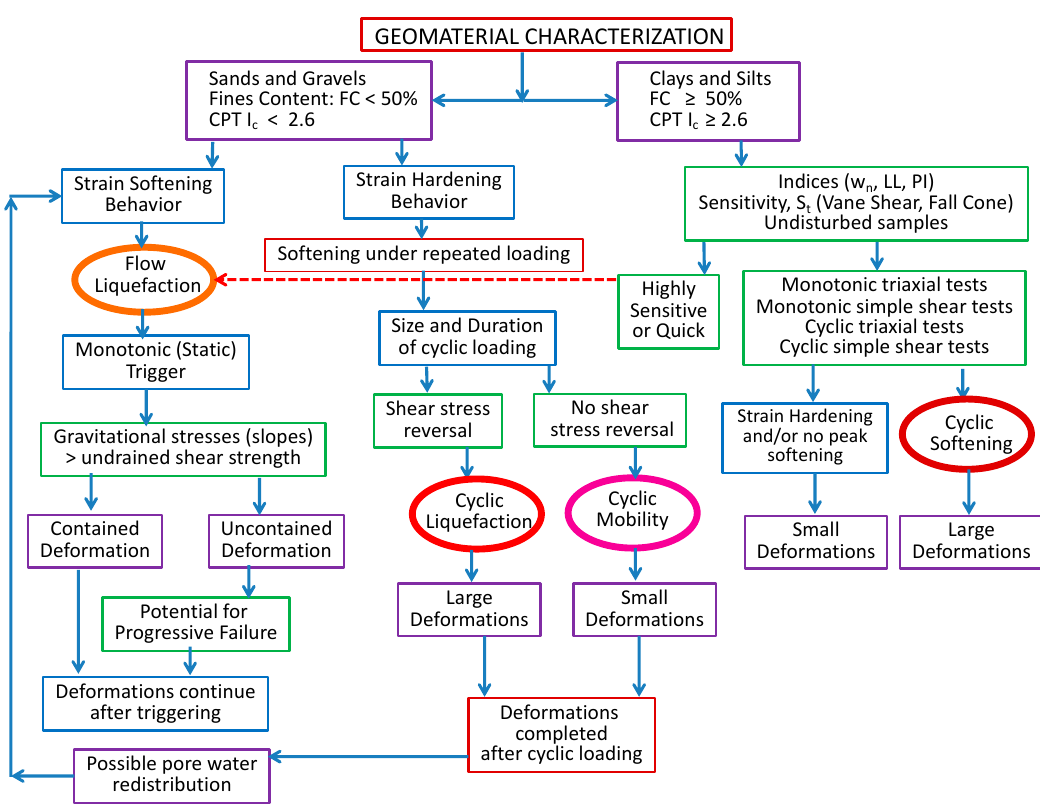
Figure 2. Flow chart showing different types of soil liquefaction: flow liquefaction, cyclic liquefaction, cyclic mobility, and cyclic softening (modified from References [41,42]).